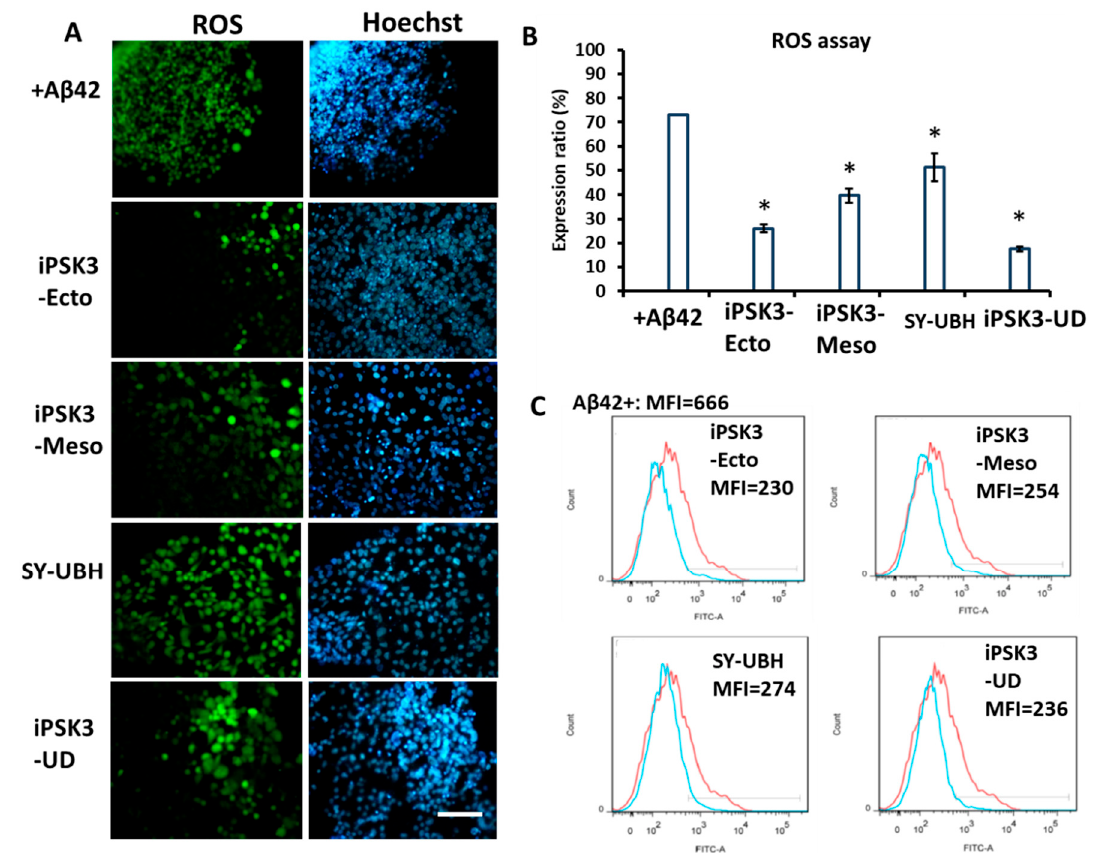
Figure 7. Effects of hiPSC-derived EVs on oxidative stress of A β 42-treated iNPC spheroid outgrowth. Day 30 cortical spheroid outgrowth was treated with A β 42 oligomers and di ff erent groups of hiPSC-EVs for three days before the analysis. ( A ) Fluorescent images of reactive oxygen species (ROS); Blue: Hoechst. Scale bar: 100 µm. ( B ) Quantification of relative ROS expression ( n = 3). The expression ratio indicates the ratio of ROS intensity (green) to the total nuclear intensity (blue). The error for the +A β 42 group is very small/zero. * indicates p < 0.05 compared to the culture treated with A β 42 oligomers. ( C ) Flow cytometry analysis for ROS expression. Red line: iNPCs treated with A β 42 oligomers (positive control); Blue line: iNPCs treated with A β 42 oligomers plus a different type of hiPSC-EVs. MFI: mean fluorescence intensity.